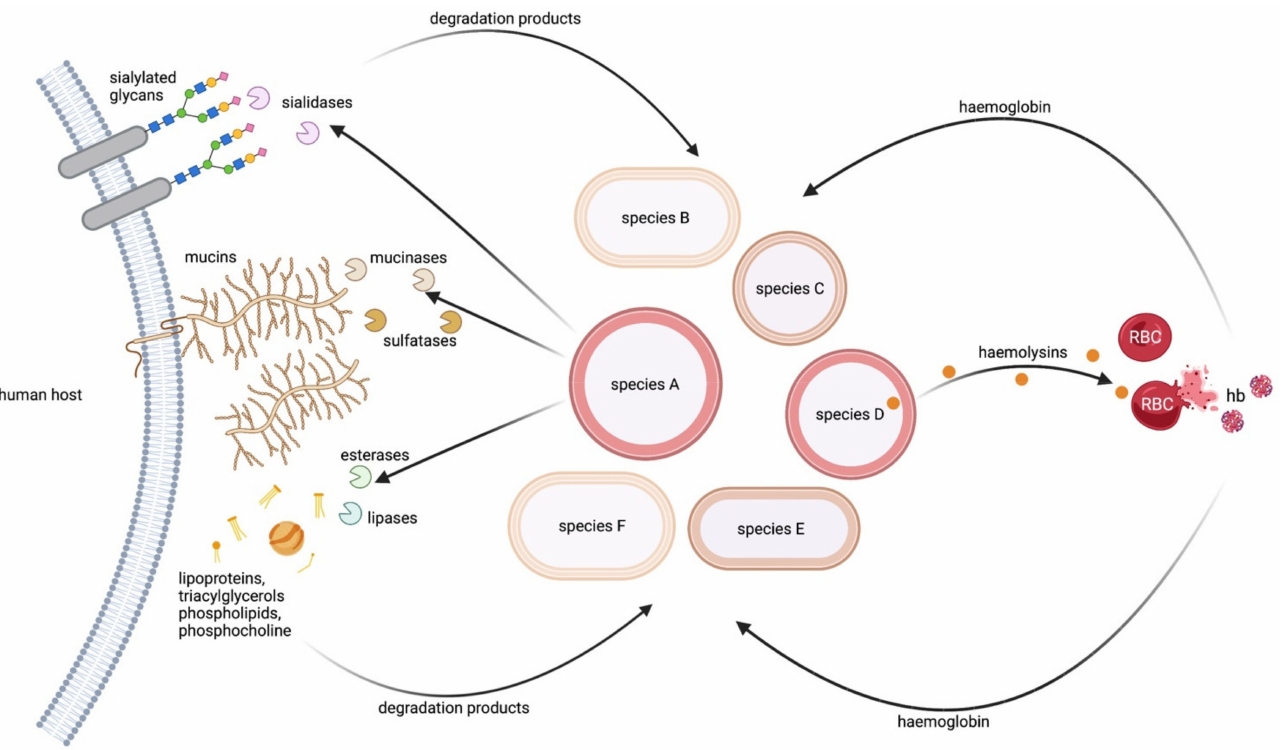
Figure 2. Release of nutrients from host macromolecules. Bacteria can release nutrients from different human macromolecules by secretion of degradative enzymes. Mucins (peptide chain with sugar side chains is shown) can be degraded by mucinases and sulphatases to release carbon and sulphate. Sialic acid is released from sialylated glycans (proteins modified with carbohydrates; here: blue square—N-acetylglucosamine, green circle—mannose, yellow circle—galactose, pink diamond— sialic acid) by the action of sialidases. Fatty acids, phosphate, carbon and nitrogen are released from lipoproteins, triacylglycerols, phospholipids and phosphocholine, respectively, by secretion of lipases and esterases. Lysis of red blood cells (RBCs) by haemolysins can release haemoglobin (hb). Not only the bacteria secreting the enzymes (here shown in red) but also other bacteria colonising the same niche might benefit from these nutrient sources, enhancing proliferation of the entire